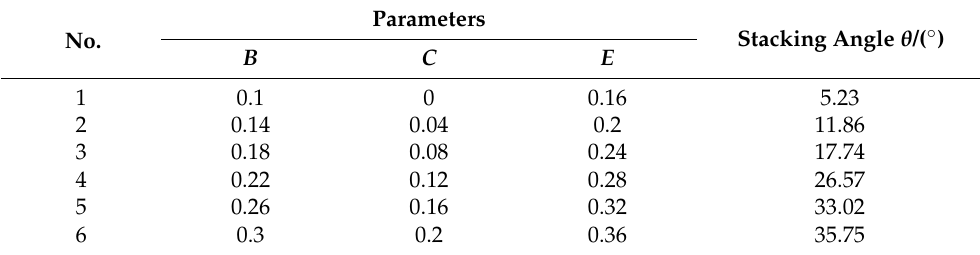
Table 5. The steepest ascent experiment scheme and results.